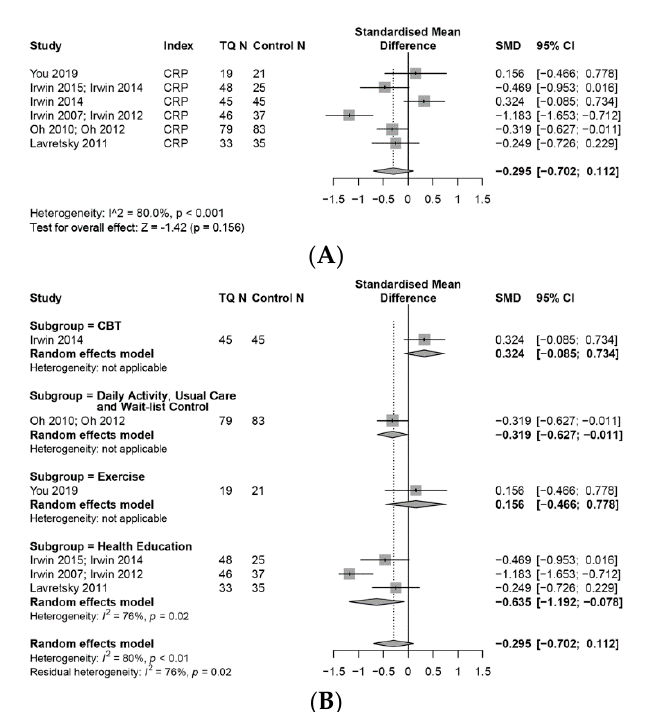
Figure 6. Forest plot for random-effects meta-analysis of the effects of TQ on levels of CRP. ( A ): The Figure6. Forestplotforrandom-e ff ectsmeta-analysisofthee ff ectsofTQonlevelsofCRP.( A ):Thee ff ects effects on the levels of CRP, ( B ): subgroup analysis of CRP based on control interventions. on the levels of CRP, ( B ): subgroup analysis of CRP based on control